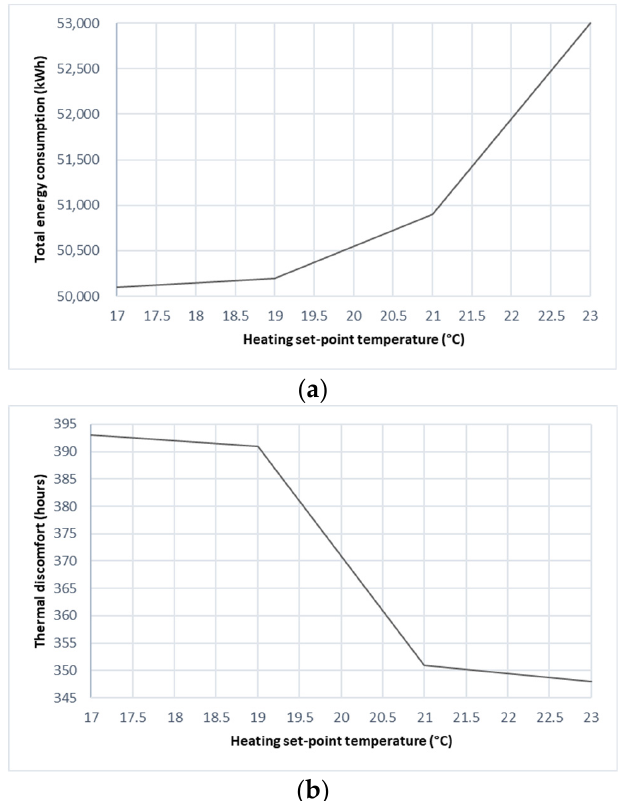
Figure 5. The effect of cooling set-point temperature on ( a ) energy consumption. ( b ) Students ther- mal discomfort hours